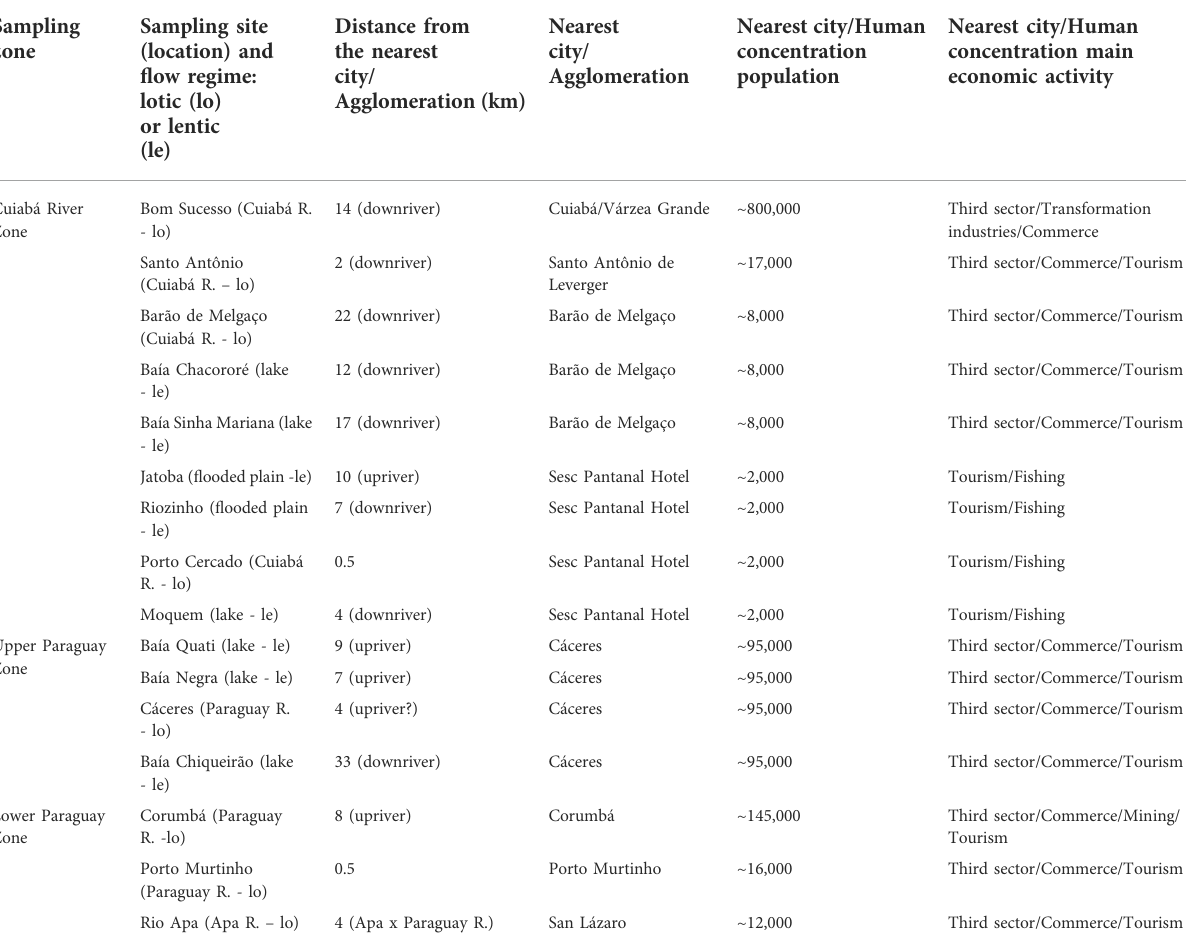
TABLE 1 Sampling sites ’ characteristics. Populations of Brazilian cities from IBGE (2021). Estimated population at Sesc Pantanal Hotel and surroundings from Marinha (2011). Population of San Lázaro, Paraguay from DGEEC (2015). Sampling